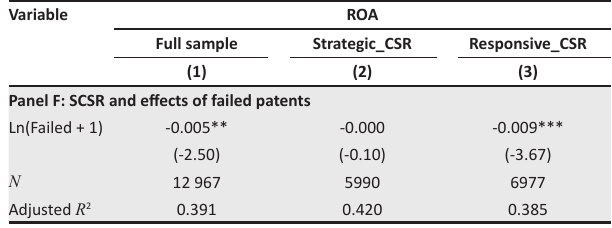
TABLE 5F: Further analyses. TABLE 5A: Further analyses.